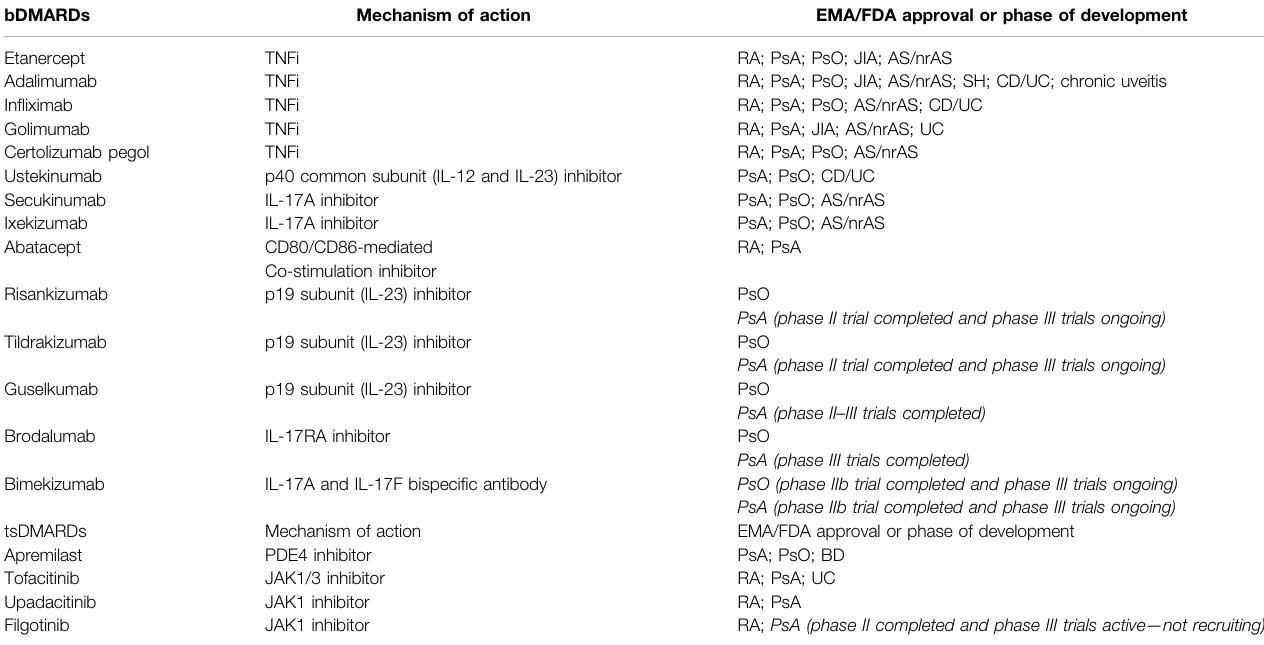
TABLE 1 | b/tsDMARDs that have been approved or are in different phases of development for the systemic management of